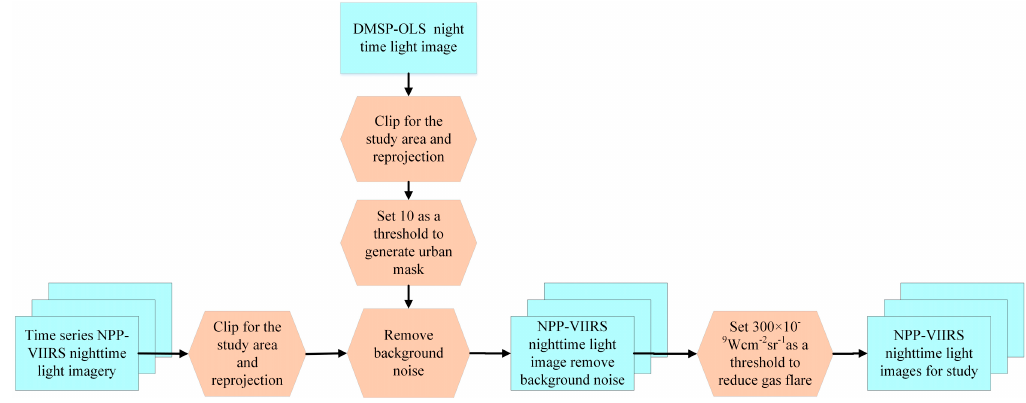
Figure 5. Processing flow of the NPP-VIIRS nighttime light images